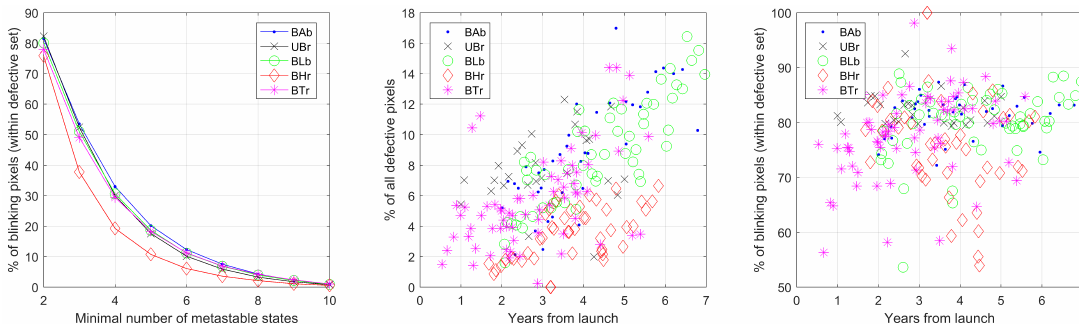
Figure 9. Results of analysis of metastable pixels. On the left side: distribution of blinking pixels as a function of the number of states. In the middle: time evolution of the percentage of all defective pixels. On the right side: evolution of the percentage of blinking pixels in the set of defective pixels.